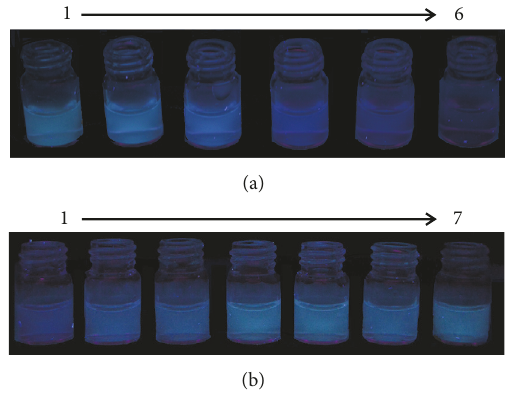
Figure 3: (a) Fluorescence photograph of F-hPEI-capped Au NPs upon different concentrations of Cr(VI): (1) 0, (2) 4.0 (3) 8.0, (4) 32, (5) 40, and (6) 80 𝜇 M. (b) Fluorescence photograph of F-hPEI- capped Au NPs upon different concentrations of Fe(II): (1) 0, (2) 2.9 × 10 2 , (3) 5.8 × 10 2 , (4) 8.6 × 10 2 , (5) 1.2 × 10 3 , (6) 1.4 × 10 3 𝜇 M, in the presence of 80 𝜇 M Cr(VI), and (7) the blank solution without Cr (VI) and Fe